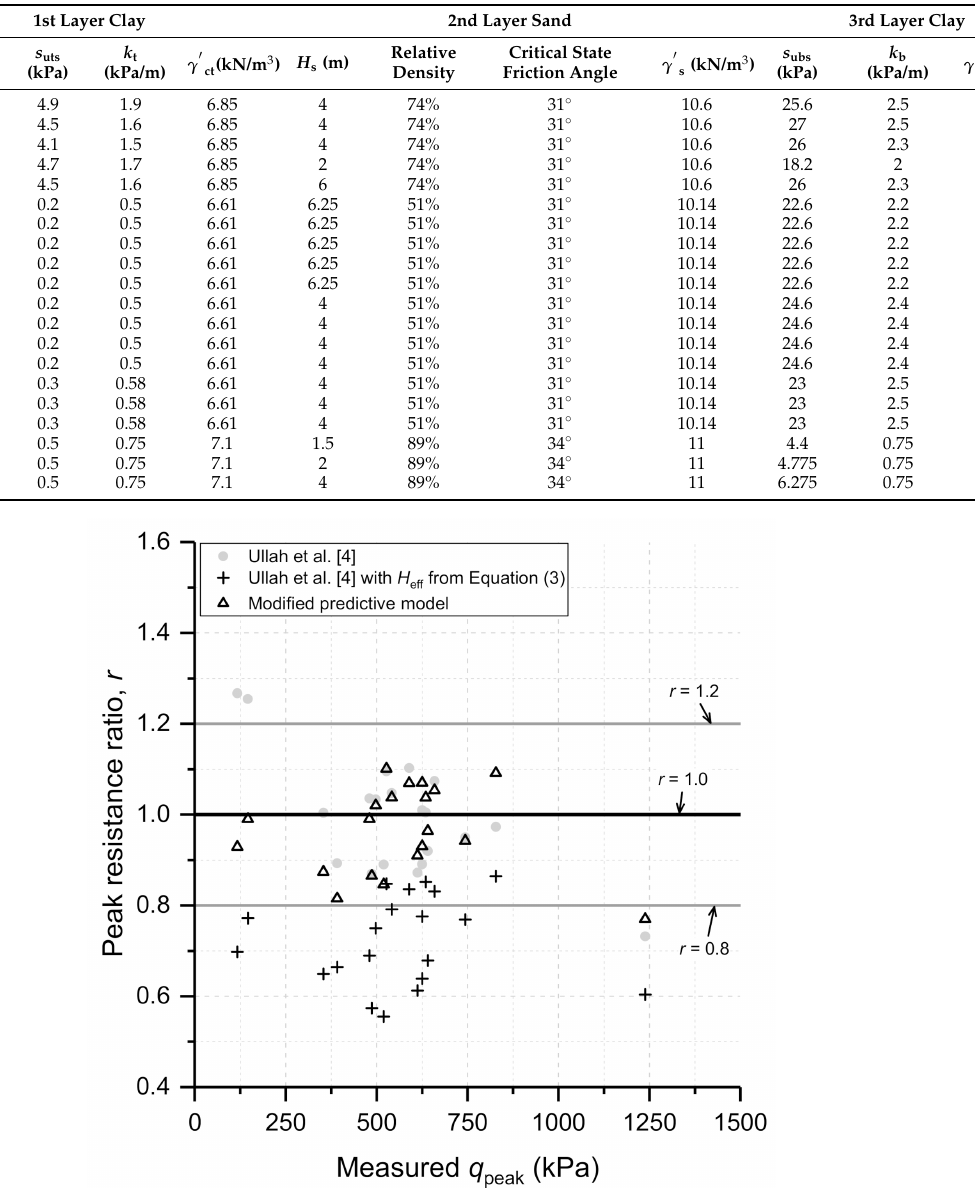
Table 1. Geometries and soil properties for centrifuge tests considered for parameter optimization [1,19].